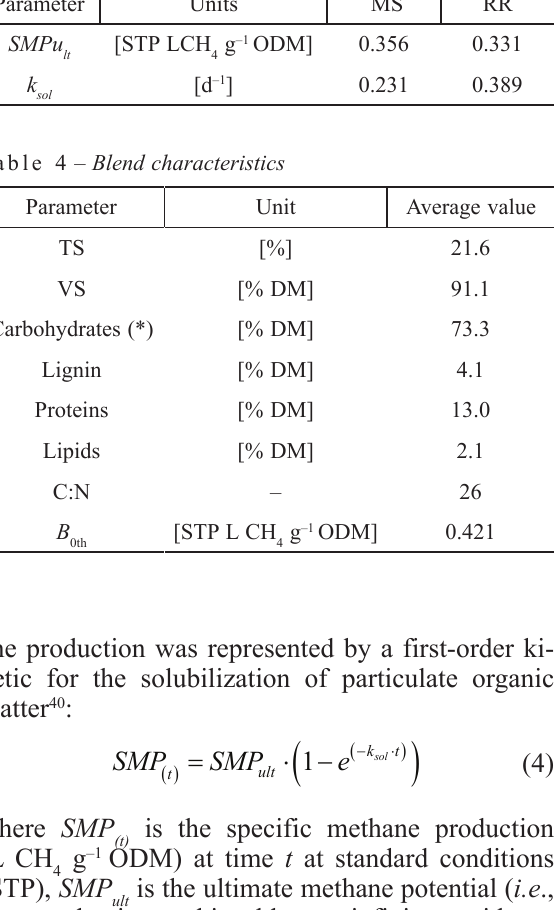
Table 3 – Evaluation of solubilization parameters Parameter